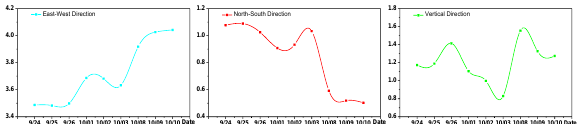
during holidays.